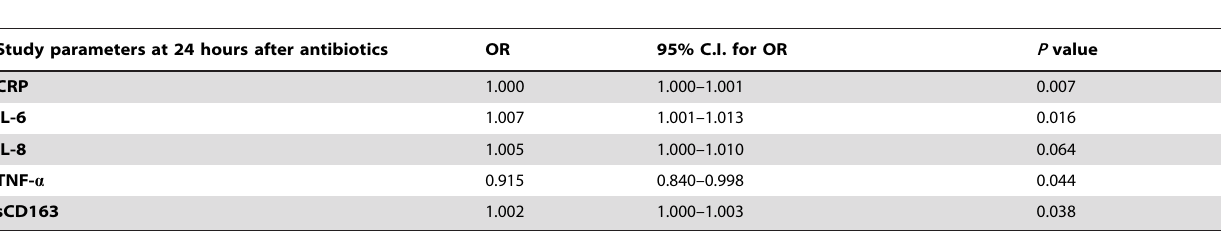
Table 8. Prognostic predictors of neonatal sepsis 24 hours after initiation of antibiotic therapy.